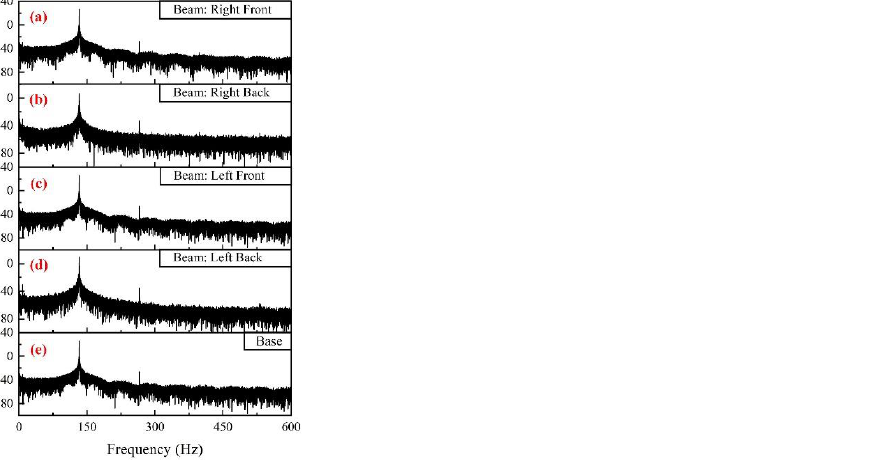
Figure 11. Vibration frequency diagram of beams and base only with additional mass a 1 = 1 g.